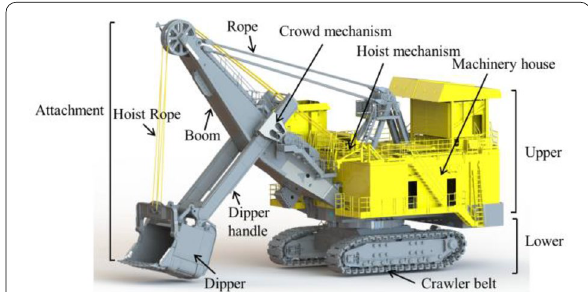
Figure 1 For a WK-55-type electric shovel, the capacity of the dipper